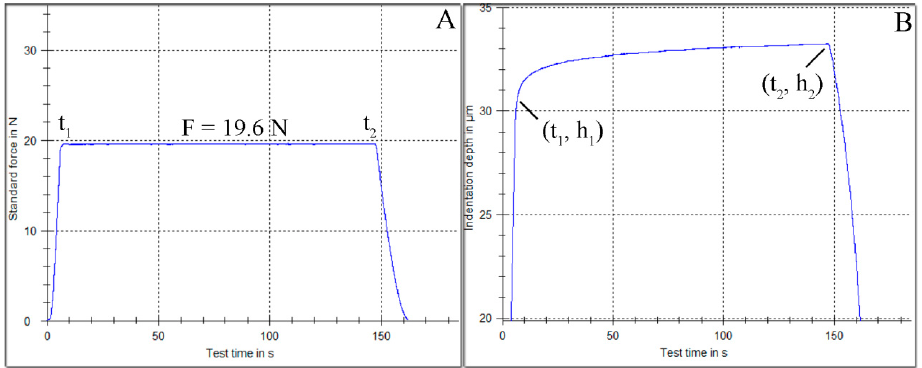
Figure 1. Representative force-indentation depth curves from all materials tested.